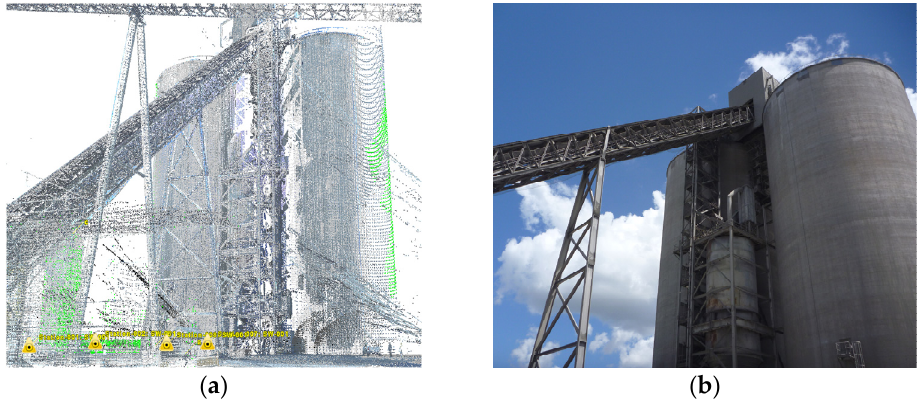
Figure 2. Points of clouds ( a ) obtained from 3D laser scan of industrial equipment ( b ).